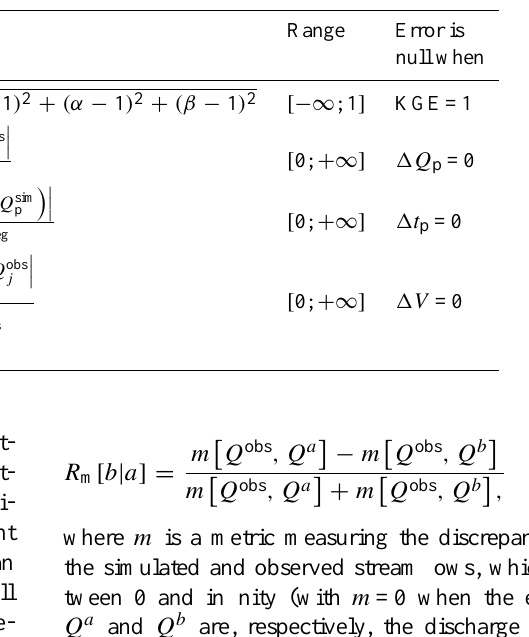
Table 3. Evaluation criteria used in this study, where r is the Pearson correlation coefficient between the simulated and observed flow, β is the ratio between the mean simulated and mean observed flow, α is the ratio between the simulated and observed flow variance, Q sim Q obs are, respectively, the simulated and observed discharge at the time steps j , j 1 and j 2 the beginning and the end of the flood event. Q sim p j and Q obs p are the simulated and observed peak flow amplitude. t(Q sim p ) and t(Q obs p ) are the time to the simulated and observed peak flow amplitude, with t beg and t end the beginning and the end of the flood